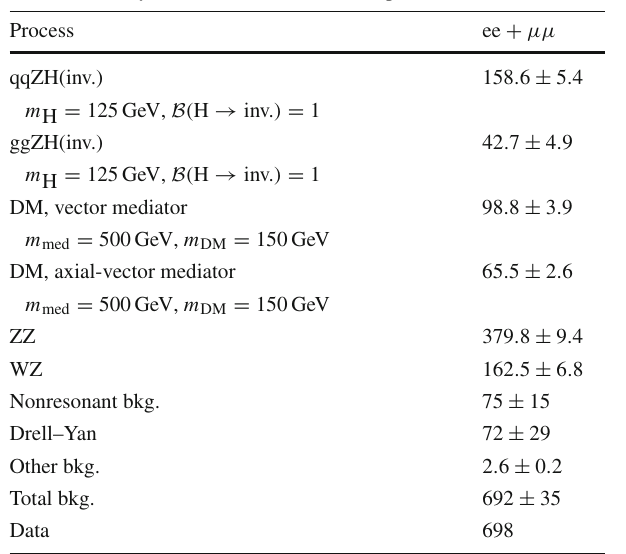
-based analysis. The combined T